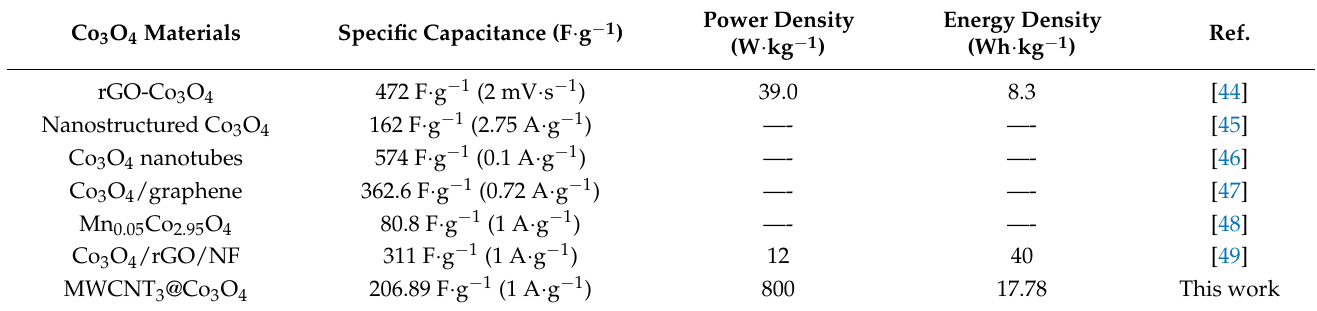
Table 2. The electrochemical performance of a summary of related Co 3 O 4